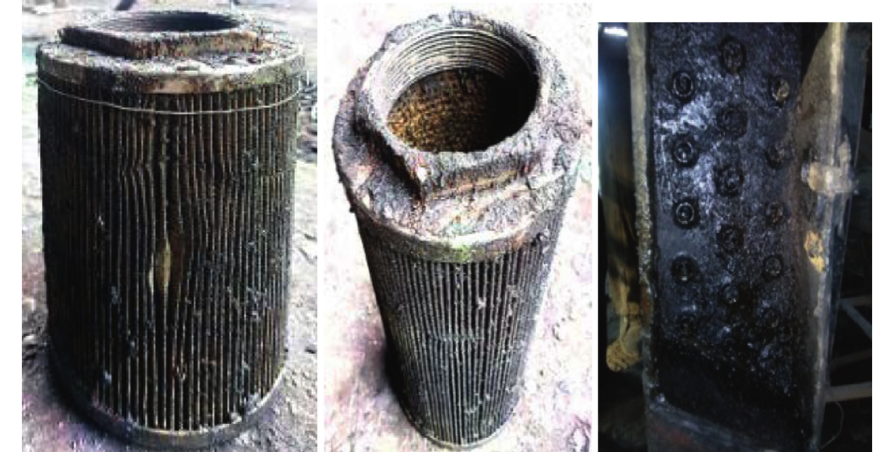
Figure 2: Suction strainer and radiator choked by Table 1: Test report of new hydraulic oil HFDU-68 done at Testing Laboratory of M/s Sun Oil Company Pvt. Ltd., Kolkata. S.